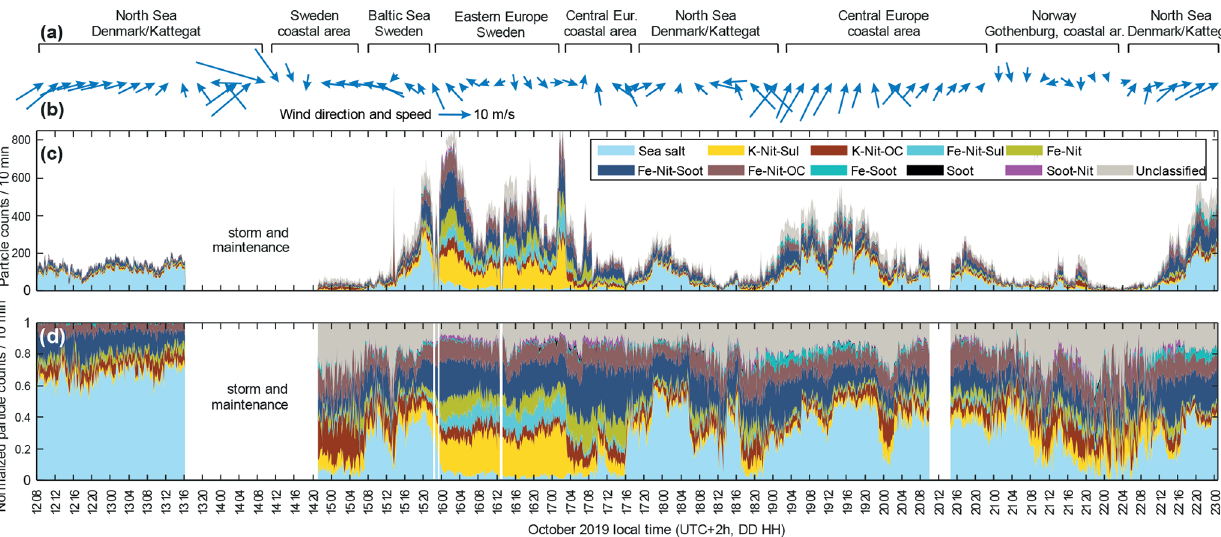
Figure 3. (a) Air mass origin obtained from analysis of the HYSPLIT back trajectories shown in Fig. S2 (top line: > 12h, bottom line: < 12h). (b) Local wind data from a meteorological station 8km south of the measurement site. (c) Time series of particle counts reveal stable conditions with dominating sea salt during strong wind from the sea and higher particle numbers as well as transient features, e.g., from possible nighttime particle formation events at light winds from land and along the coastline. (d) The same data are the same as in (c) , with normalization to total particle counts revealing the relative contributions of each particle class. High numbers of sulfate- containing, potassium-rich particles can be noticed during air mass transport from eastern Europe, where the heating season has already started and wood, as well as coal, combustion is common. Wind from central Europe transports mainly internal mixtures of Fe, organics and nitrate. Soot signatures are recognized in many particles, but instead pure soot particles and Fe–soot mixtures without secondary material are limited to southwestern onshore winds, pointing to contributions from marine